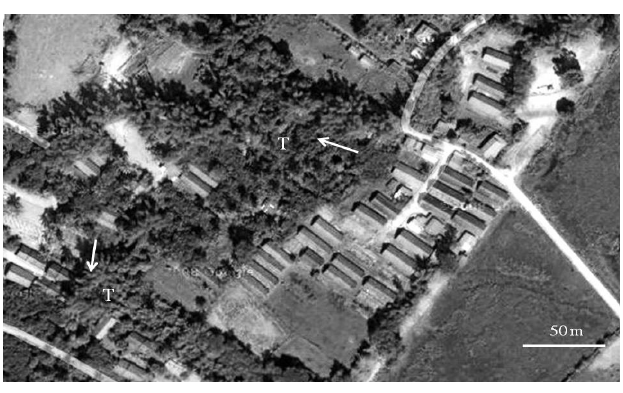
Figure 2. Poultry pens densely situated in the same area and surrounded by trees (T) in the poultry clusters in Nakhon Phanom province.